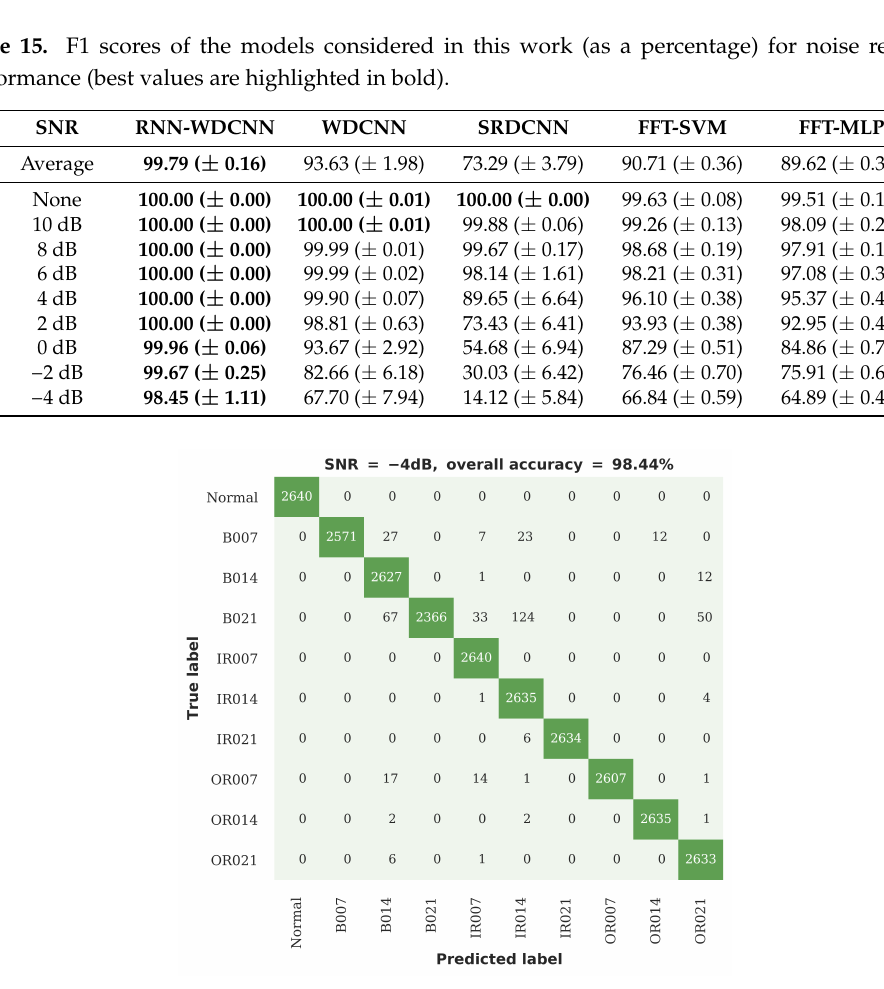
Figure 14. Confusion plot for the RNN-WDCNN model in the case of severe additive noise (SNR − 4